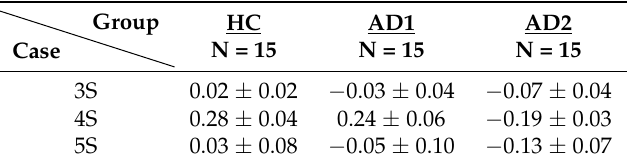
Table 7. Comparison of MSE-based weighted sum values among the HC, AD1, and AD2 groups. (The values are labeled as mean ± SD.)